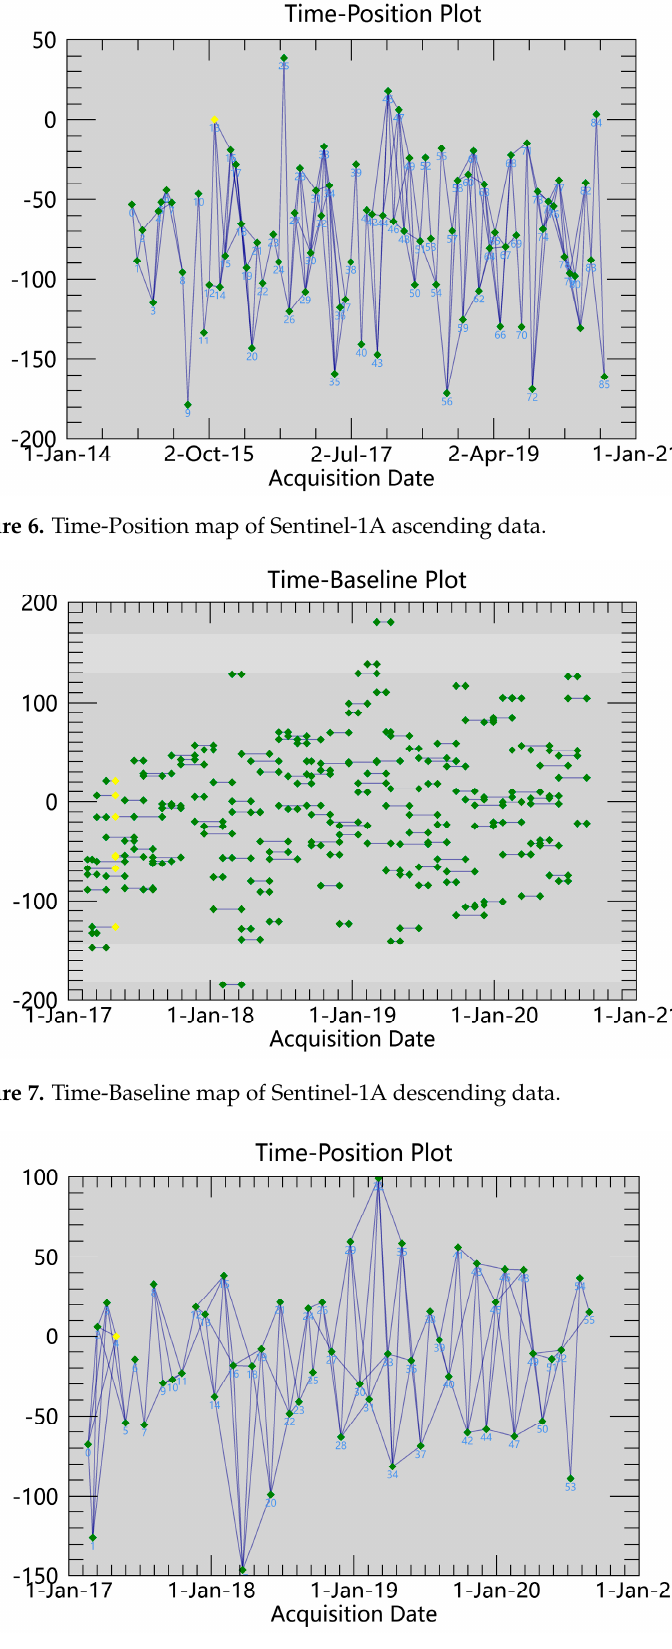
Figure 8. Time-Position map of Sentinel-1A descending data.